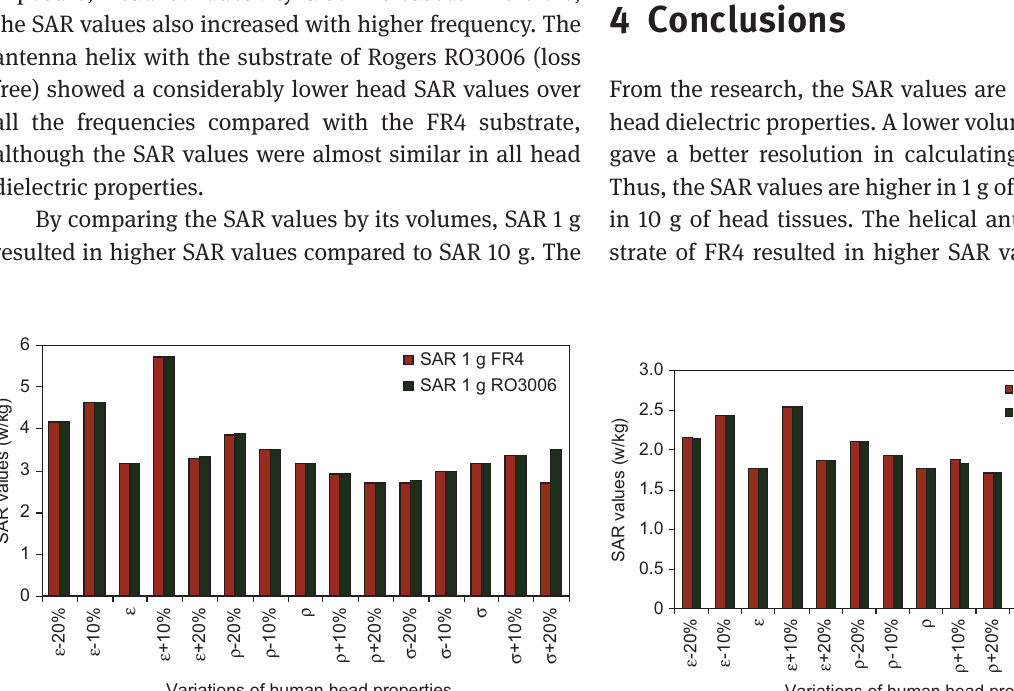
Figure 10 SAR 10 g of two different substrates at 1900